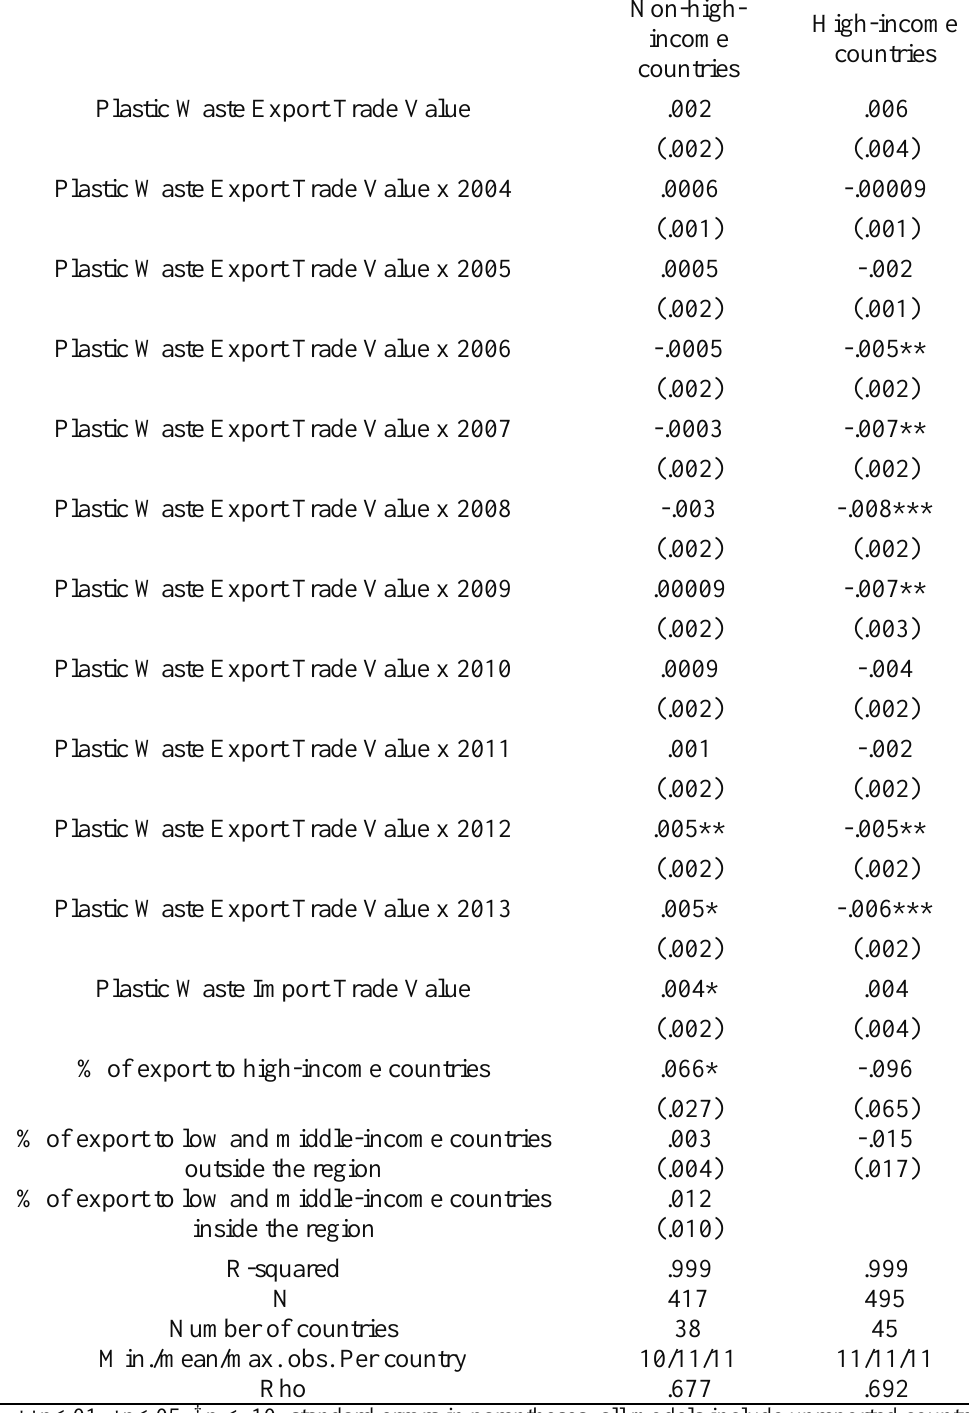
Table 9 Regression of GDP per capita, 2003-2013, on Plastic Waste Export Trade Value and Other Selected Independent Variables: Two-Way Fixed Effects PW